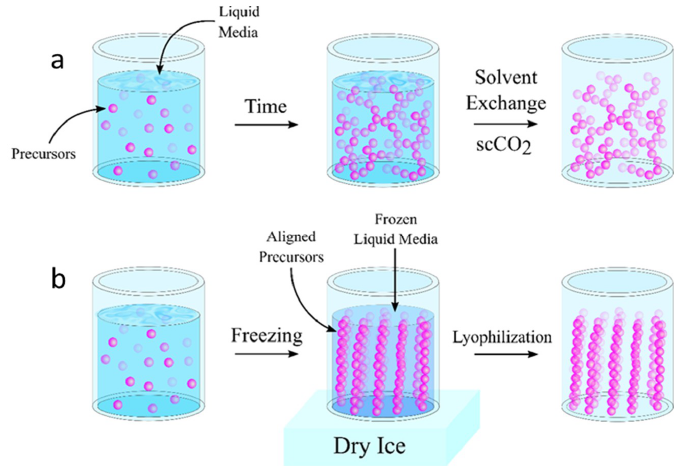
Figure 1. Comparison of aerogel fabrication strategies showing typical transitions into an aerogel. ( a ) shows the supercritical drying process where precursor materials undergo gelation prior to supercritical drying. Often, these processes include a solvent exchange step after gelation to provide better fluids for supercritical drying. ( b ) shows a standard freeze‐drying technique where an aqueous solution is frozen and the ice crystal formation dictates the alignment of the precursor materials and thus, the resulting pore structure of the dried aerogel.